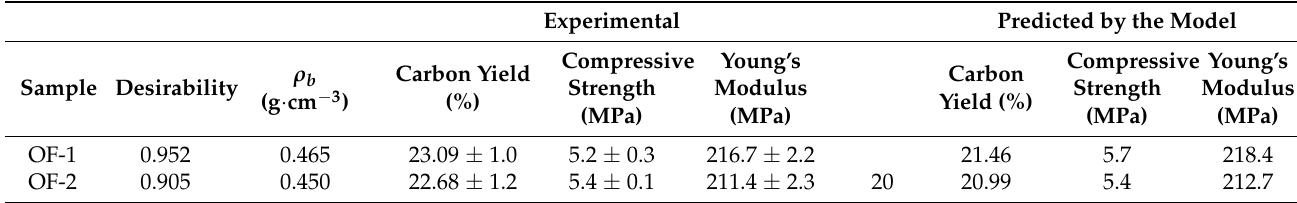
Table 5. Validation of the model: the measured values versus predicted